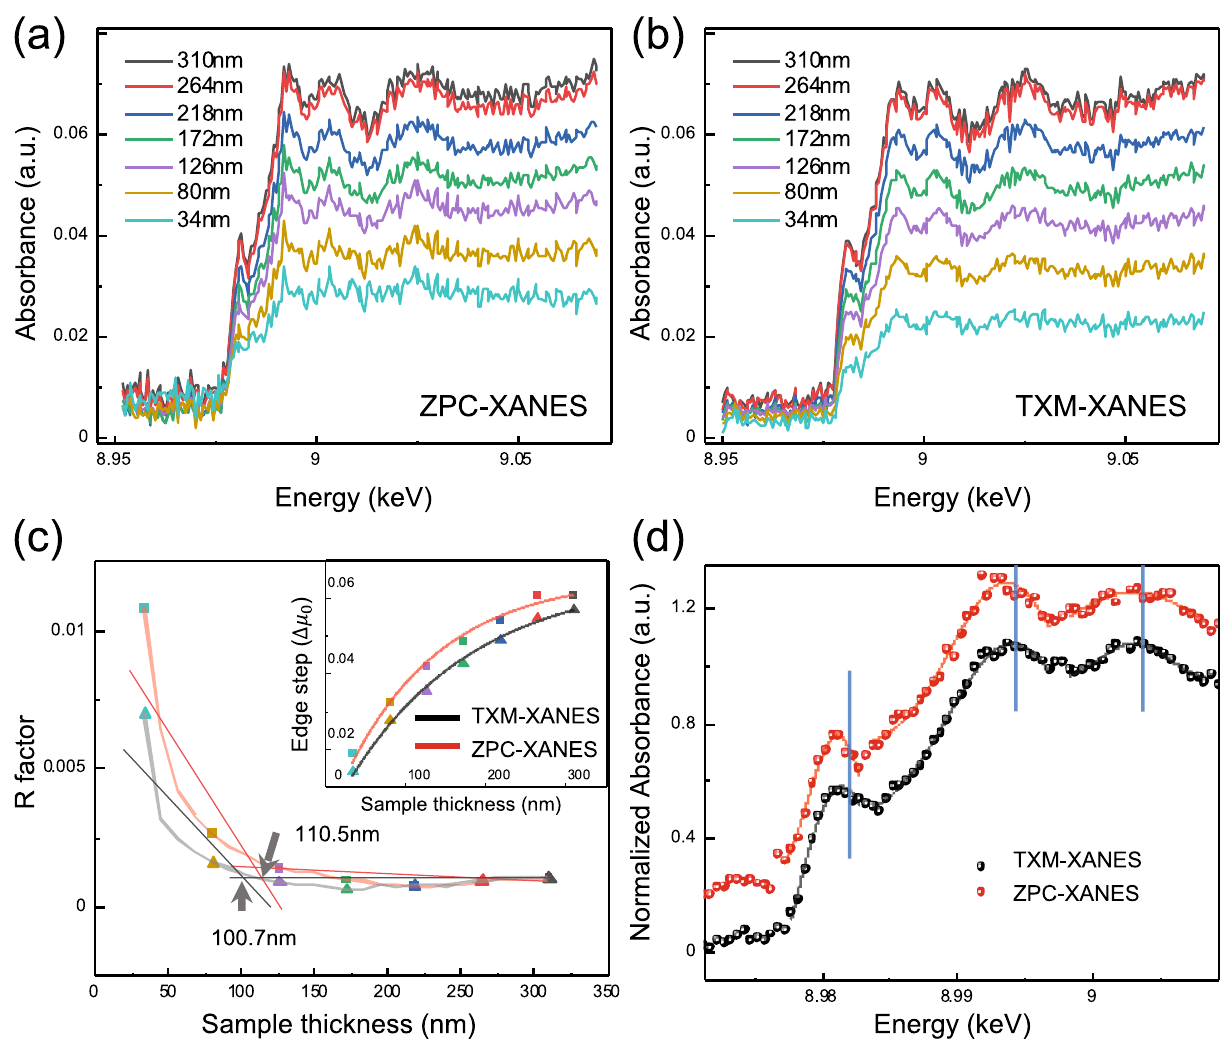
Figure 3. XANES analysis depends on sample thickness ( a , b ) XANES spectra of each thickness from ZPC-XANES and TXM-XANES. ( c ) Estimation of minimum thickness for XANES analysis from R factor ( (cid:31) i 2 (data-fit ) / (cid:31) i 2 (data ) ). The reasonable minimum thickness is 110.5 nm at ZPC-XANES and 100.7 nm at TXM-XANES (gray arrows). The inset shows the non-linear relationship between the edge step of XANES spectra and Cu thickness. The colors of each dot are related to the colors of thickness from ( a , b ). ( d ) Normalized XANES spectra for ZPC (red dots) and TXM-XANES (black dots) at 287 nm thickness. The solid lines indicate the location of the peaks by using a Gaussian curve fitting. The first peaks are at 8981.23 eV (ZPC-XANES) and 8981.56 eV (TXM-XANES). The second peaks are at 8993.68 eV (ZPC-XANES) and 8994.11 eV (TXM- XANES). The third peaks are at 9003.07 eV (ZPC-XANES) and 9003.11 eV